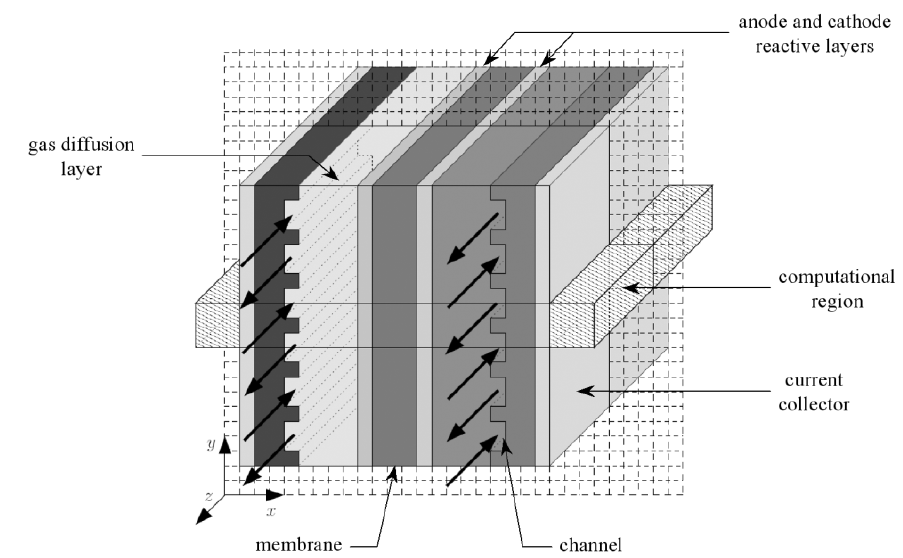
Figure 1. Internal structure of a single fuel